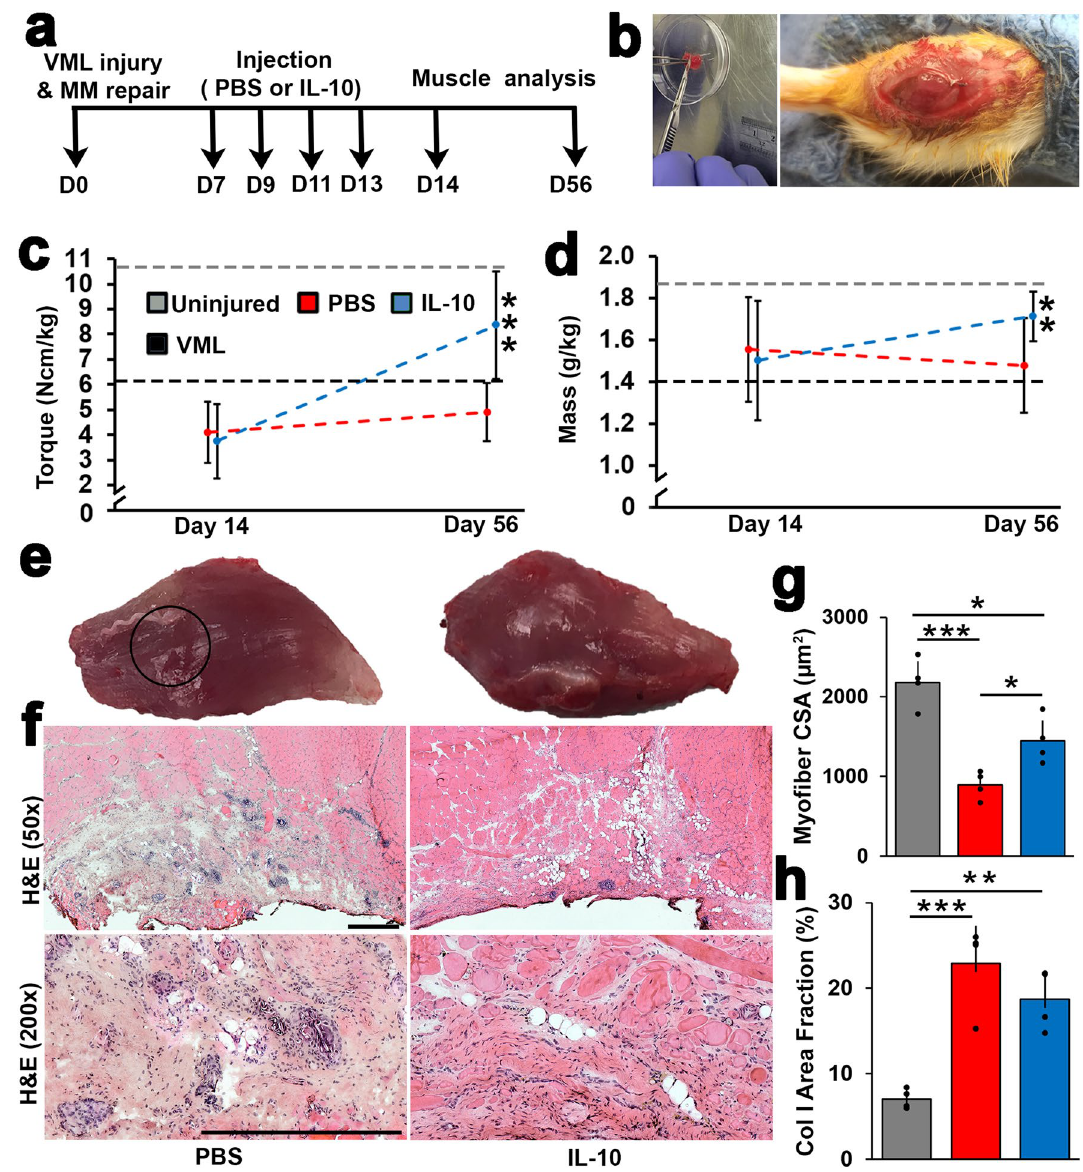
Figure 2. Delayed IL-10 delivery improved functional and structural recovery following VML repair. ( a ) VML injuries were created and repaired using autologous MM. One week following repair, recombinant rat IL-10 was injected at the repair site every other day for one week. ( b ) Autologous MM grafts were prepared by mincing all of the removed muscle plug using a scalpel and scissors. The resulting MM paste was packed into the defect site; the fascia at the defect site was sutured to secure the MM paste in place. ( c ) Tibialis anterior (TA) electrophysiological measurement of mean peak contractile torque (Ncm/kg rat body weight) and ( d ) mass (g/ kg rat body weight) for IL-10 treated and PBS controls groups were assessed at 14 and 56 DPI. Average torque and mass from uninjured controls (accessed in this study) and VML with no repair groups at 56 DPI (accessed in previously published study 76 ) were presented as 2 parallel dashed lines. Error bars are presented as ± standard deviation, with n = 5 animals per treatment group and timepoint. ( e) Representative image of gross appearance of TA for PBS (left) and IL-10 (right) at 56 DPI are presented. Black circle indicates VML injury and repair site. ( f ) Representative H&E stained TA muscle cross-sections collected at 56 DPI from PBS and IL-10 groups at 50 × and 200 × show regions of tissue healing, cell infiltrations and the anterior TA surface. Scale bar = 250 µm. Cross-sections were quantified for ( g ) collagen I area fraction (% Col I) and ( h ) muscle fiber cross-sectional area (µm 2 ). Group means + SD are presented; n = 4/group. The *, **, and *** indicate statistically significant difference of p < 0.05, p < 0.01, and p < 0.001 between